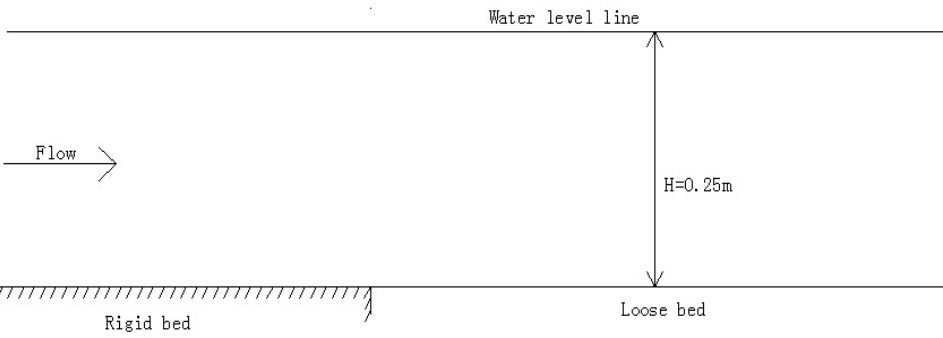
Figure 6. Schematic view of the entrainment experiment.